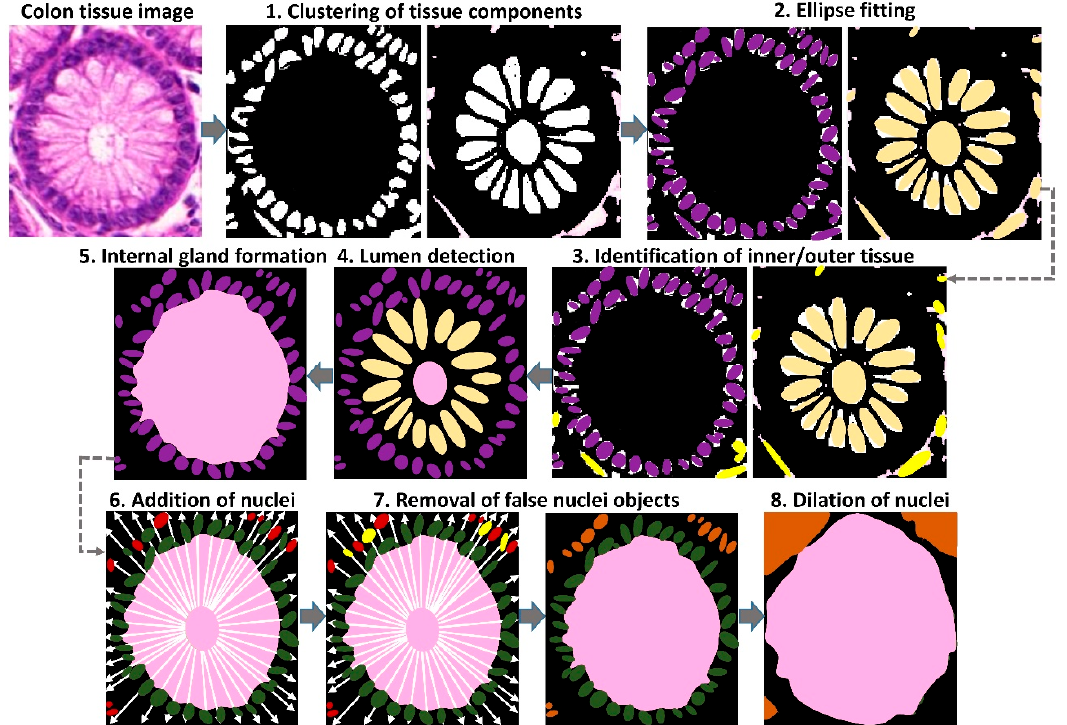
Figure 6. Schematic workflow of the proposed gland segmentation method. Figure shows one glandular region cropped from an image captured at 20× magnification.